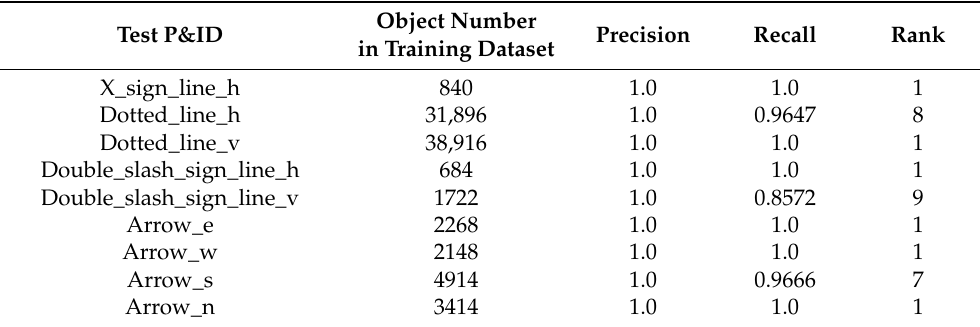
Table 3. Performance evaluation result by line sign and flow arrow types in test